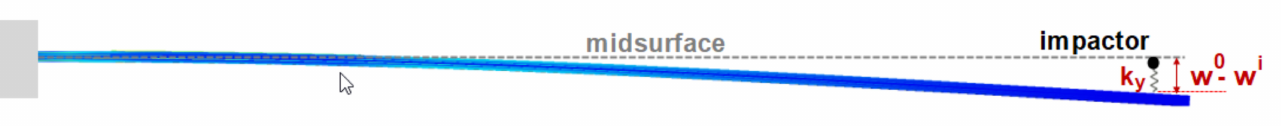
Figure 3. Modeling of impactor–target contact during